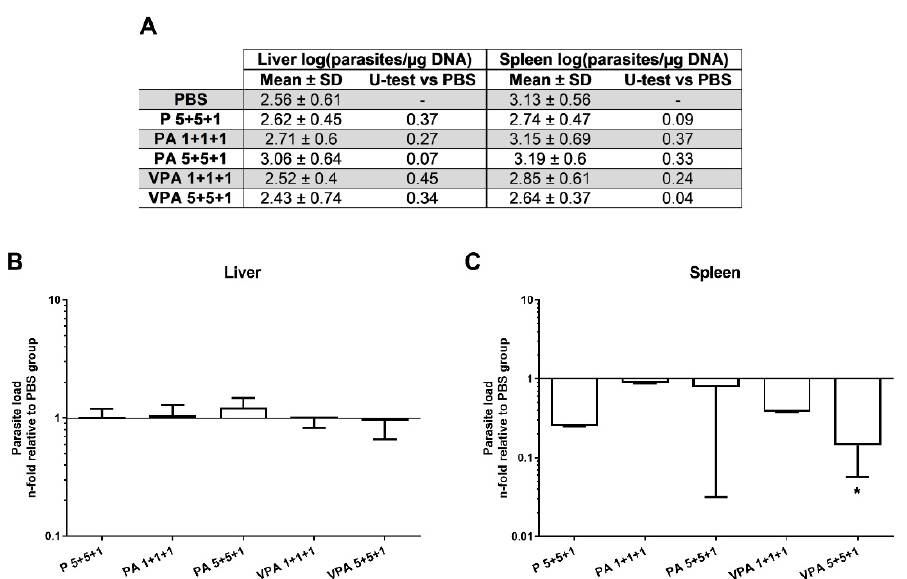
Figure 4. Parasite load in vaccinated hamsters after L. infantum infection. The parasite loads in the liver and spleen were analyzed by qPCR 12 weeks after infection ( A ). The results are represented as the mean ± SD of the relative units (RU) for each group ( n = 9) in the liver ( B ) and spleen ( C ), calculated as the number of parasites per µg of hamster DNA with respect to the mean of the control group. Significant differences between vaccinated groups and the control group are indicated (Mann–Whitney U test): * p < 0.05.